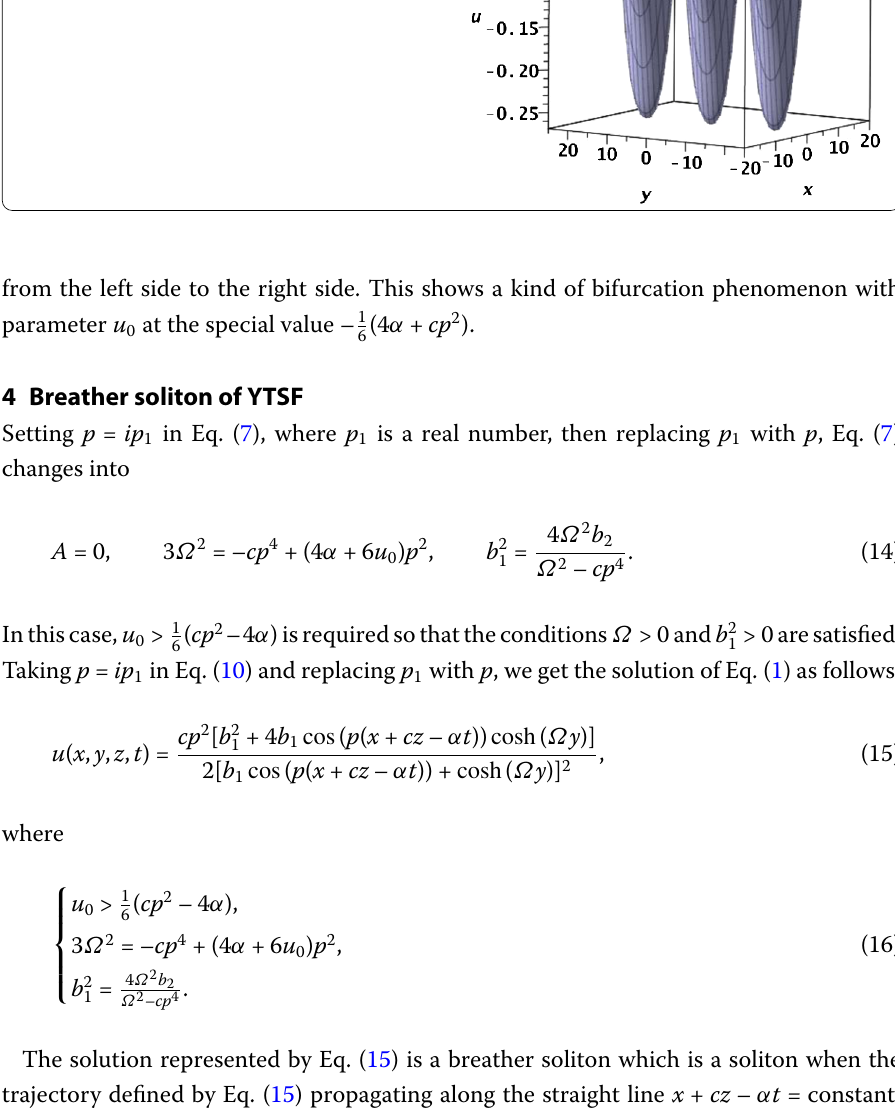
Figure 2 The periodic solitary solution (12) with u 0 = –1 , c = –1, α = 1 18